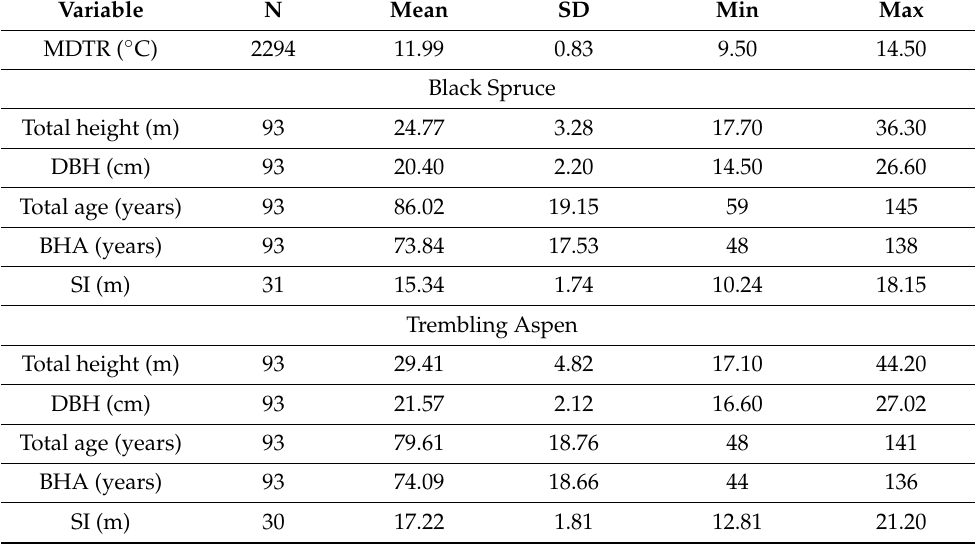
Table 1. Summary statistics (N = number of samples; SD = standard deviation) for mean diurnal temperature range (MDTR), total height, DBH, total age, breast height age (BHA), and site index (SI) for black spruce and trembling aspen trees from northern Ontario, Canada, used in this study. Variable N Mean SD